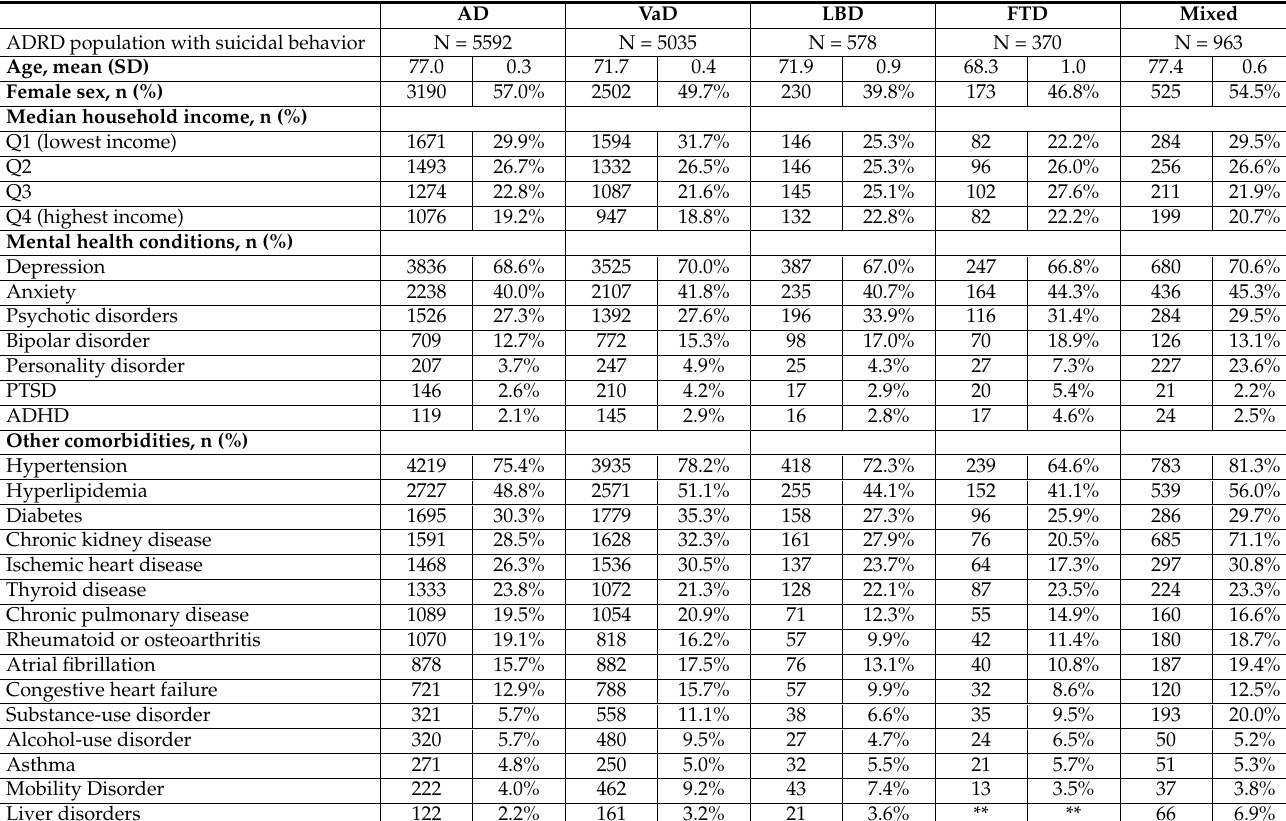
Table 1. Demographic and clinical characteristics of people with Alzheimer’s disease (AD) and AD-related dementias and a suicidal behavior-related hospitalization. Data from the Nationwide Readmissions Database, 2016–2018, in the United States. AD VaD LBD FTD